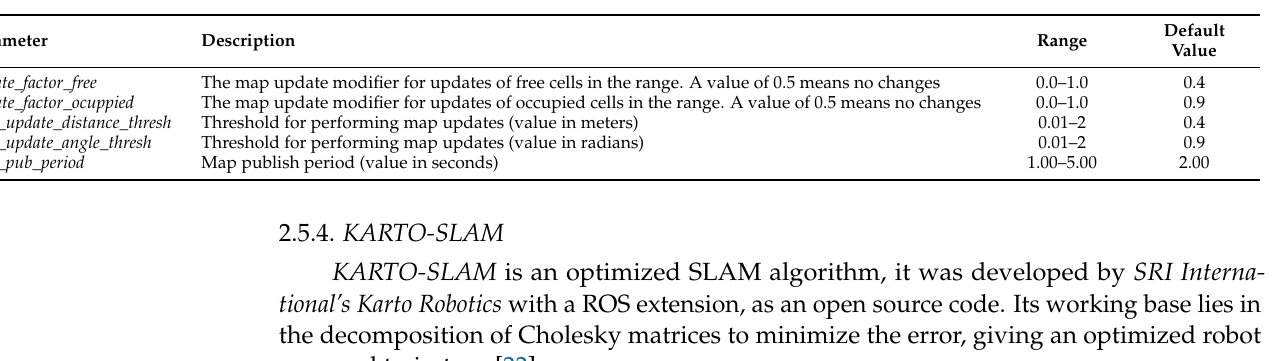
Table 3. List of HECTOR-SLAM